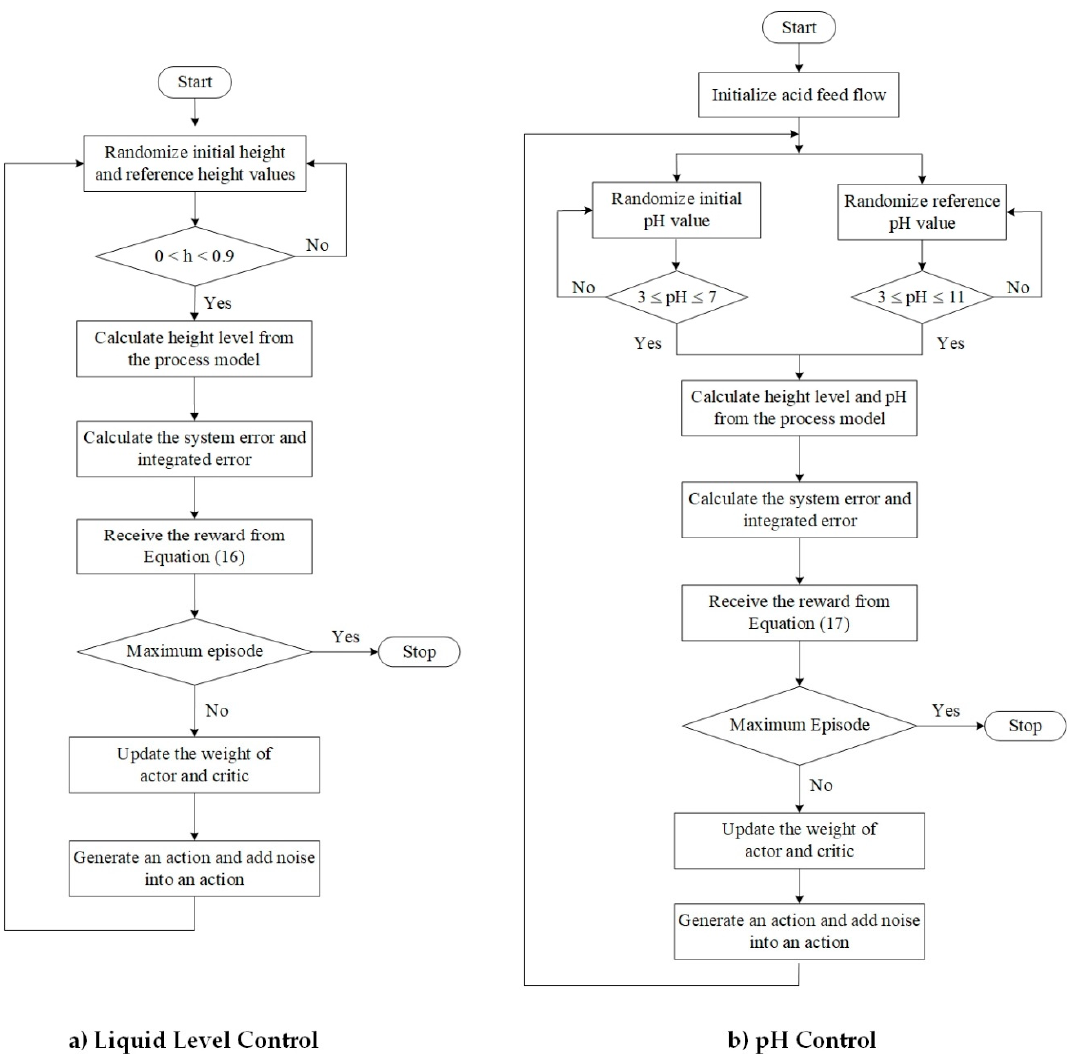
Figure 10. Simple flow diagrams of the RL training step for ( a ) liquid level control and ( b ) pH control.